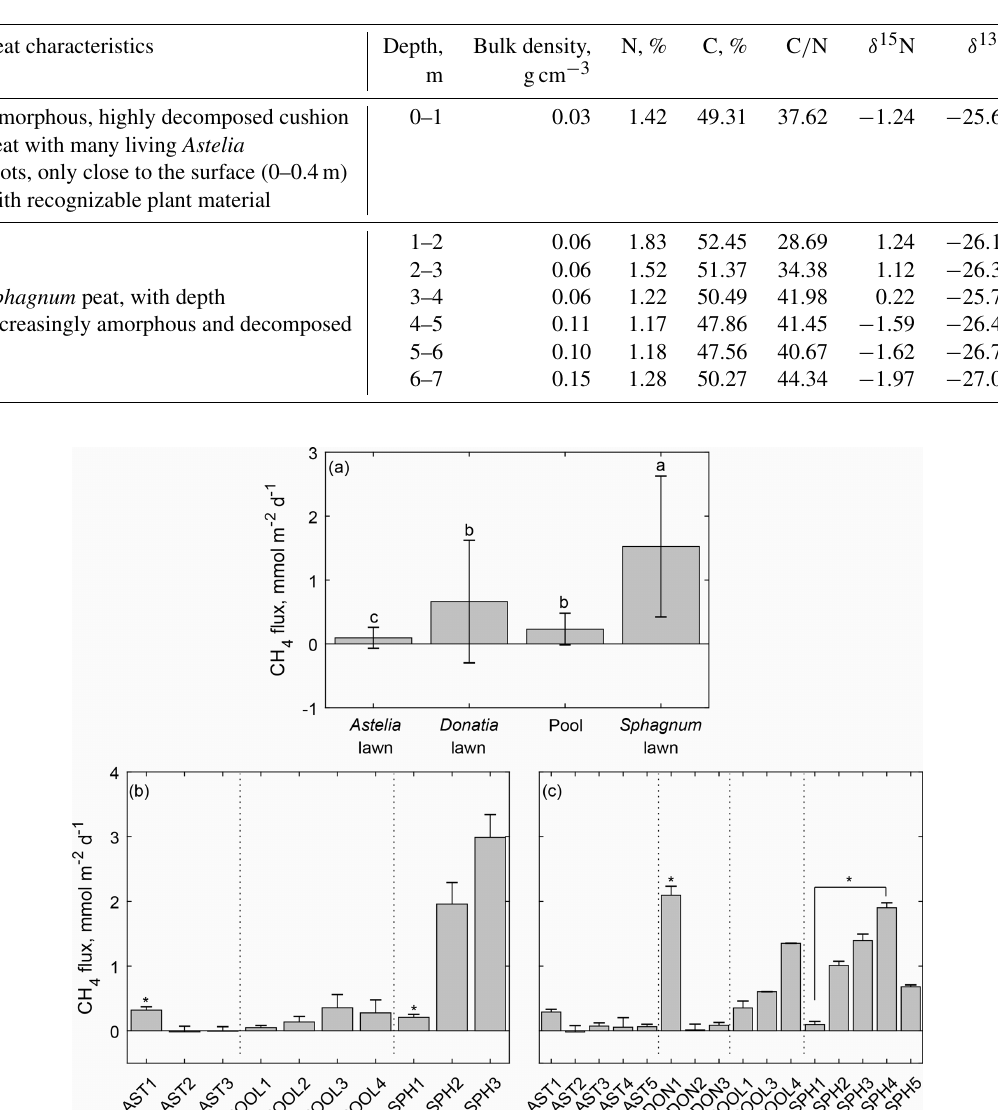
Table 3. Summary of peat characteristics obtained from two peat cores taken in Astelia lawns in a Patagonian cushion bog. Data were averaged over the respective depths sampled at 0.1m resolution.